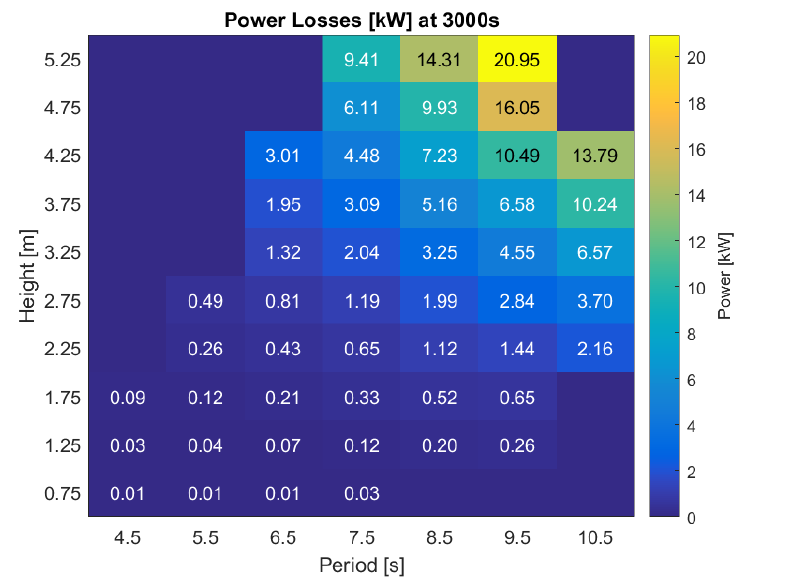
Figure 6. The power losses ( P loss ) matrix calculated in WEC–Sim across all